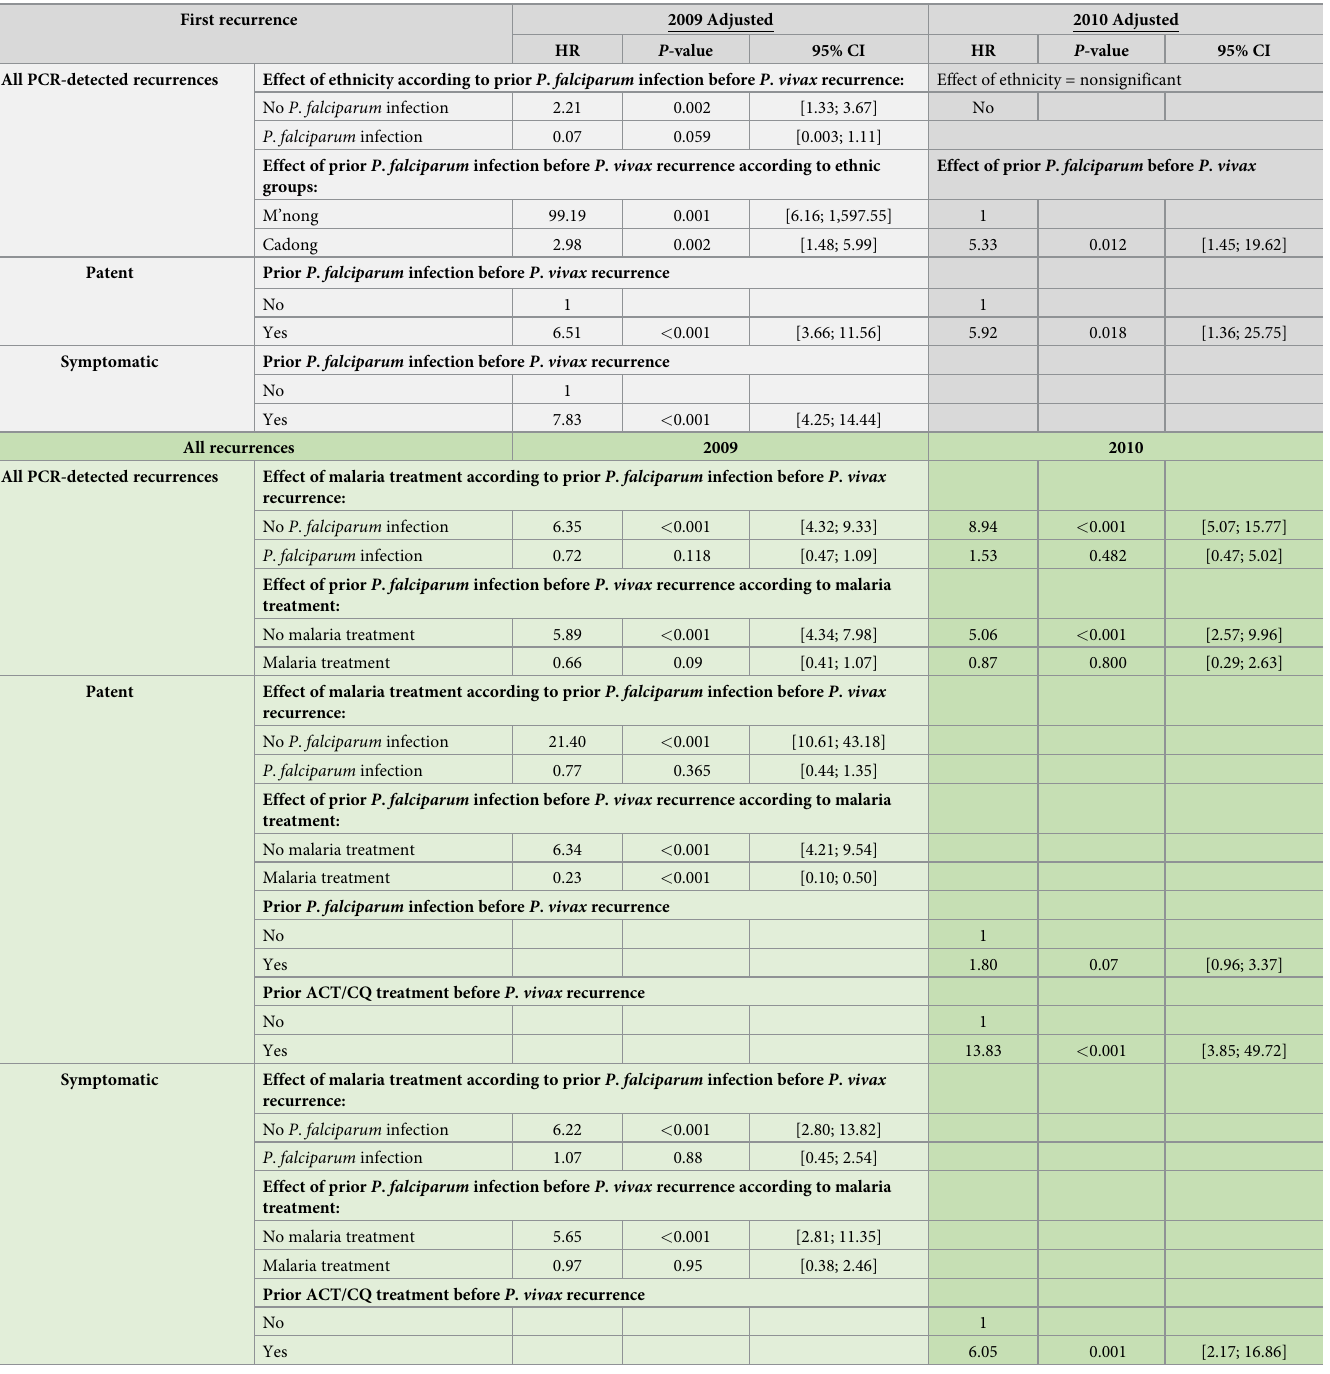
Table 4. Multivariable-adjusted risk factor analysis using Cox PH model for first recurrence and Cox CGT for all